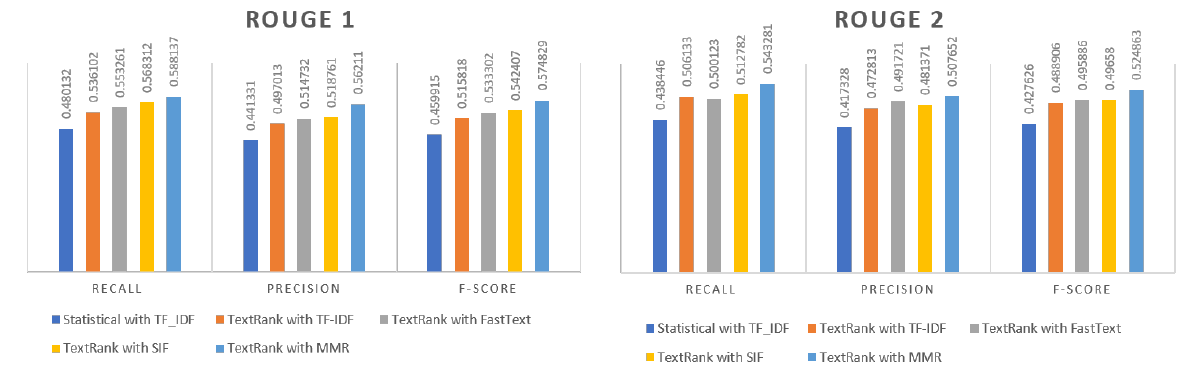
Figure 5. Graphical Comparison of the Research Results.